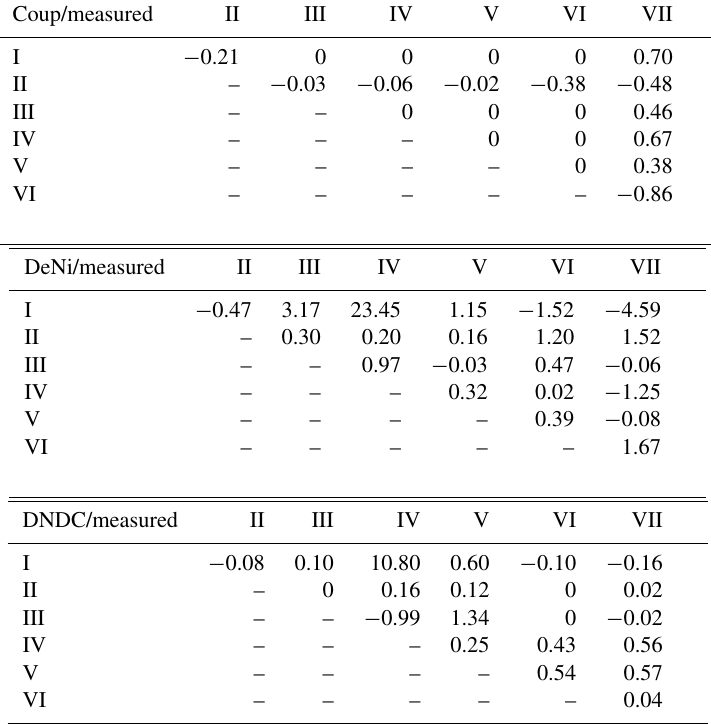
Table 4. Normalized treatment effects on N 2 + N 2 O fluxes (silt-loam soil) of modeled relative to observed results. Treatments differ with respect to NO − content (10–40mgNkg − 1 of dry soil), WFPS (73%–90%) and bulk density (1.4–1.52gcm − 3 ). Values shown are the ratio 3 of treatment differences between modeled and measured values, e.g., (( I Mod − II Mod )/ I Mod )/(( I Meas − II Meas )/ I Meas )